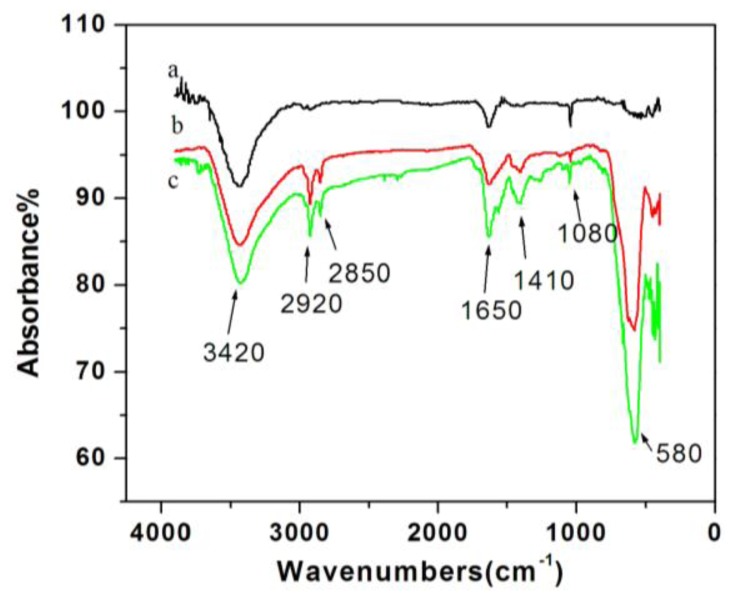
IR spectra of (a) MWCNTs -COO−/PDDA; (b) Fe3O4; (c) MWCNTs-COO−/PDDA@Fe3O4.